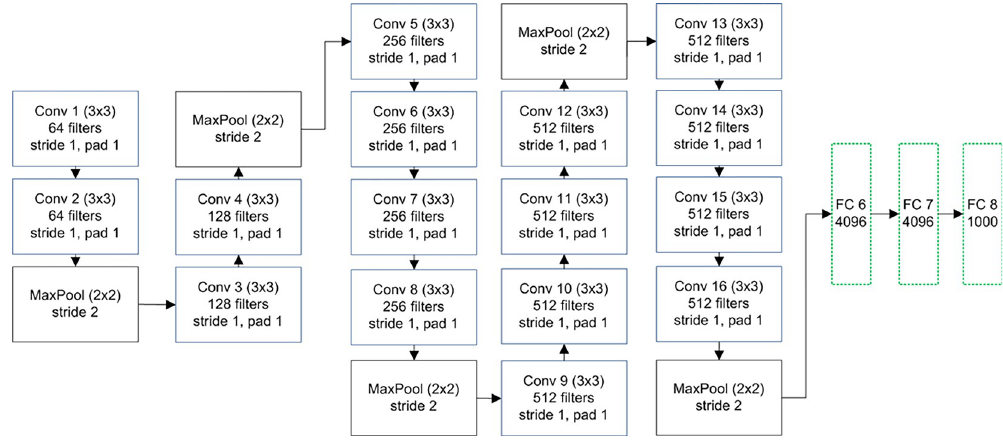
Fig 3. VGG-19 architecture for the proposed